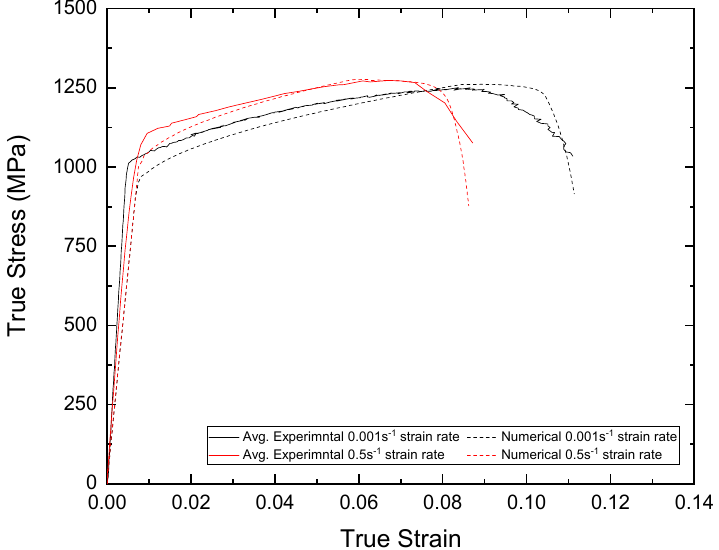
Figure 17. True stress–strain plot comparison for 0.001 s − 1 and 0.5 s − 1 strain rates for average experimental and numerical simulation using modified (Table 4) JC damage parameters. Table 5. Comparison between experimental and numerical post-yield and ultimate stress states as well as fracture strains for 0.001 s − 1 and 0.5 s − 1 strain